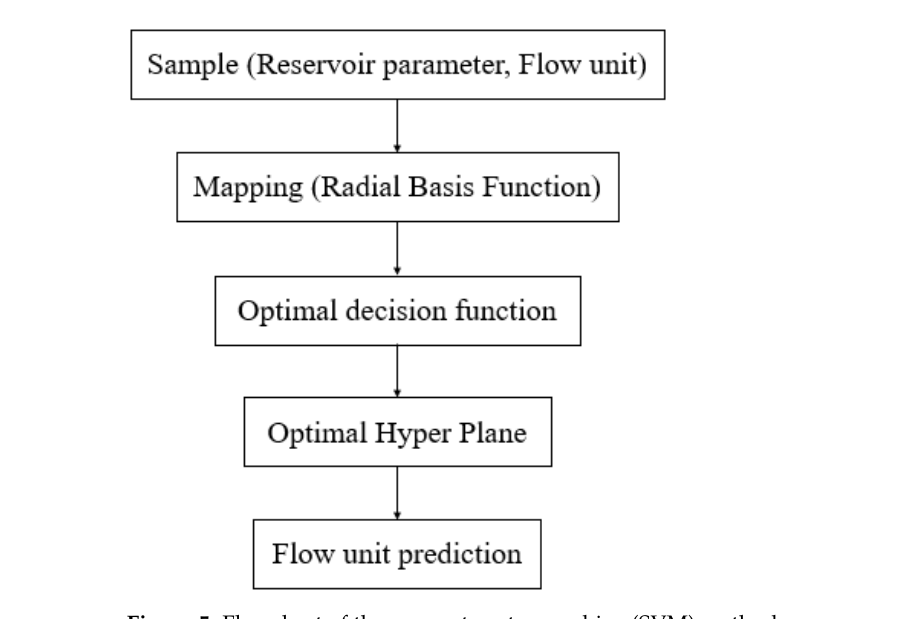
Figure 4. Structure chart of the support vector machine (SVM) method.